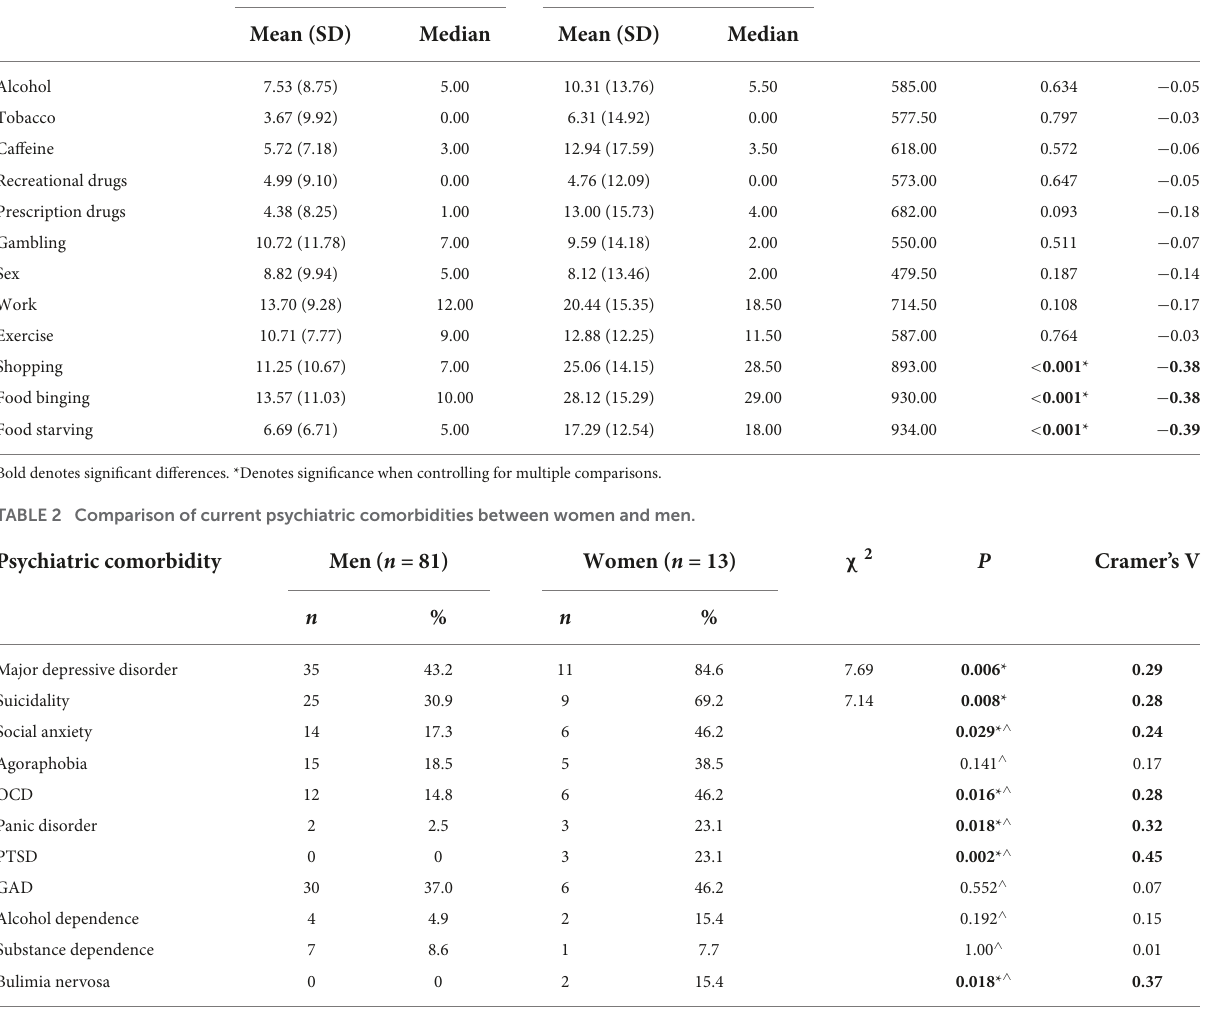
TABLE 1 Comparison of addictive behaviors as measured by the Shorter PROMIS Questionnaire between women and men. Addictive behaviors